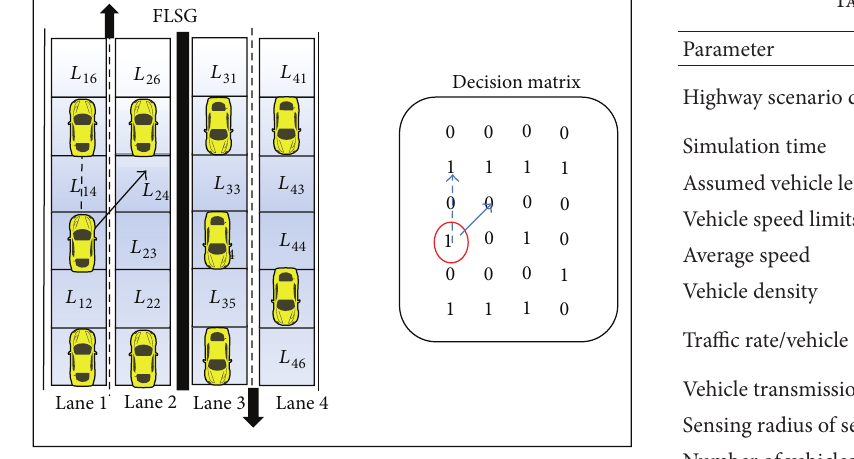
Figure 10: Abnormal outer to inner lane change with respective decision matrix.